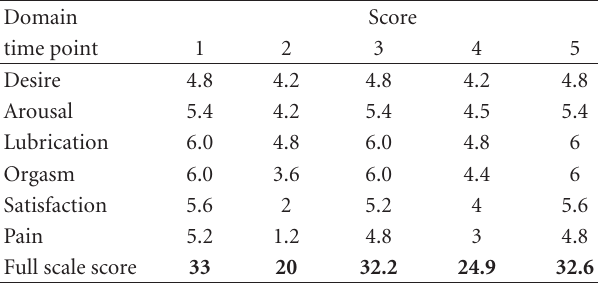
Table 2: Myomectomy patient